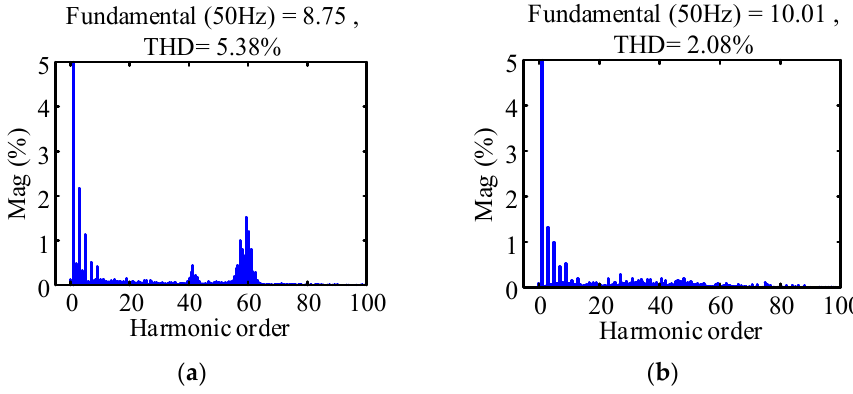
Figure 10. Simulation results of the power factor.